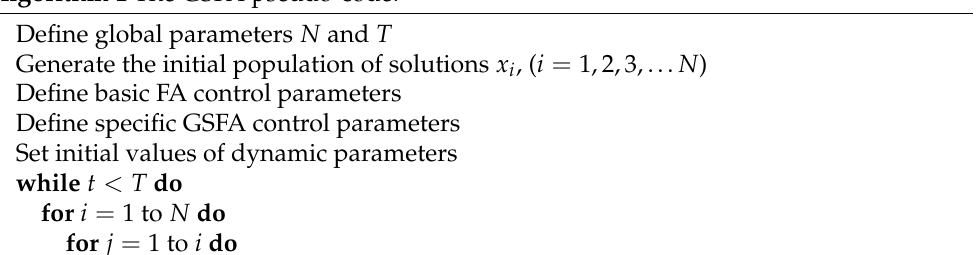
Algorithm 1 The GSFA